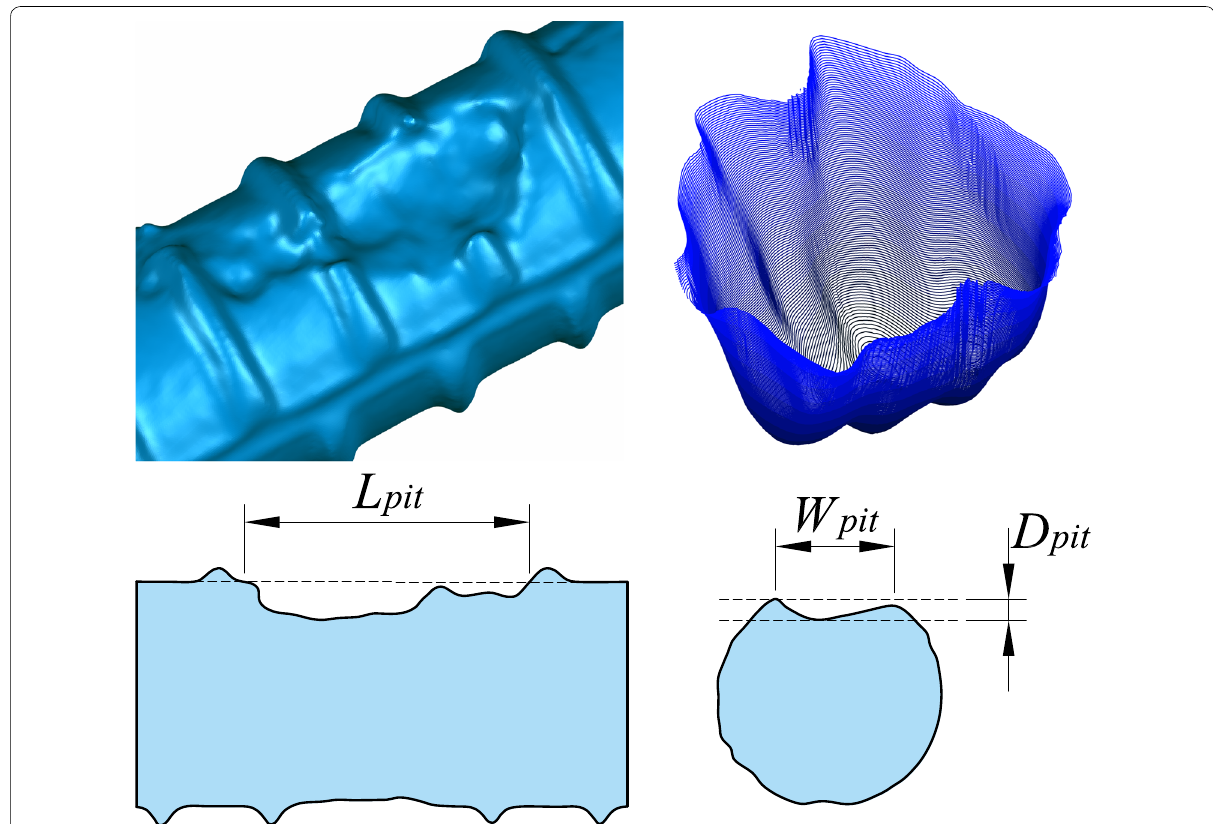
Fig. 3 3D-scanned geometry result and pit characteristics